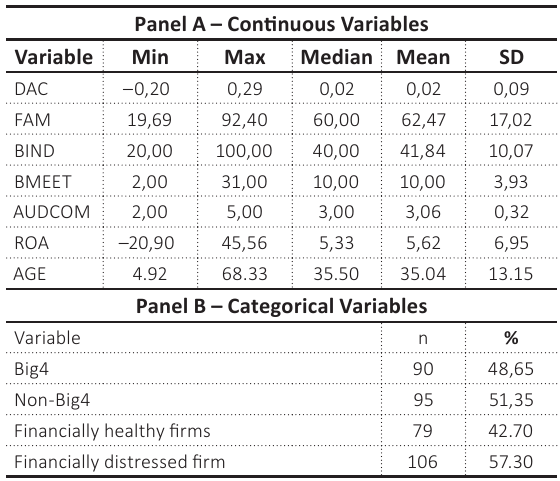
Table 2. Descriptive statistics of sample